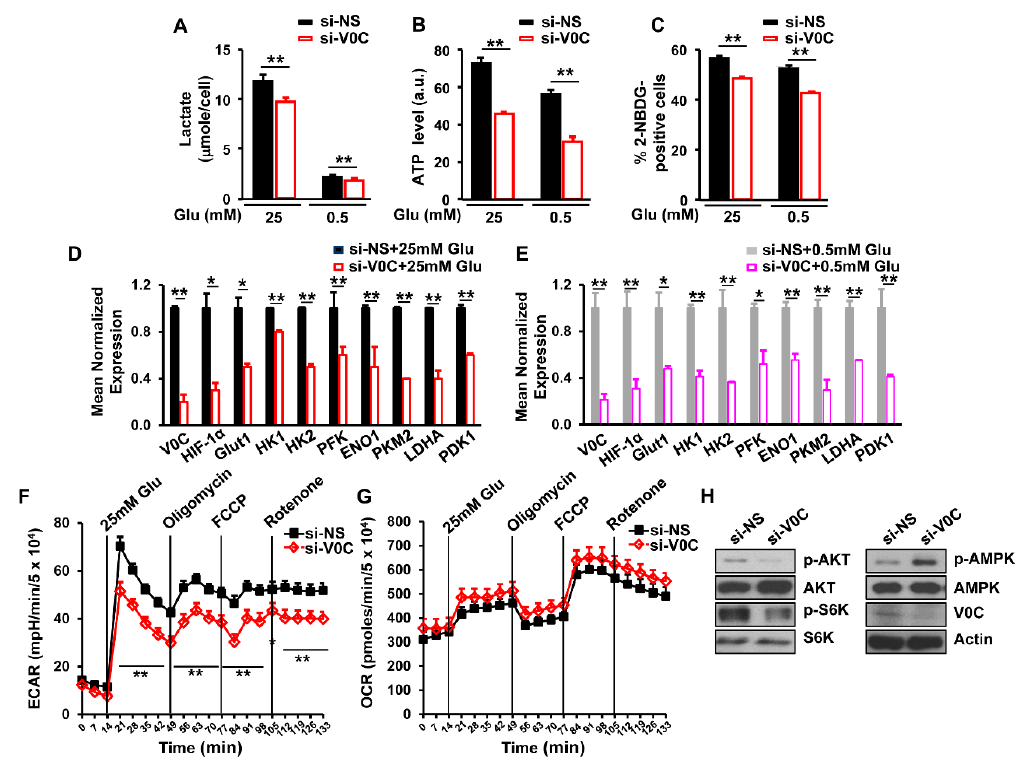
Figure 3. ATP6V0C depletion decreases glycolysis in ECCs. ( A,B ) Effects of ATP6V0C depletion on lactate or ATP levels in TE8 cells. ( C ) Effect of ATP6V0C depletion on glucose uptake. TE8 cells were transfected with NS or si-V0C for 72 h and then were treated with 10 μ M 2-NBDG, a fluorescent indicator for direct glucose uptake. Glucose uptake was analyzed by flow cytometry. ( D,E ) Gene expression related to glycolytic enzymes or glucose transport in ATP6V0C-depleted TE8 cells by qRT-PCR. ( F ) Extracellular acidification rate (ECAR) or ( G ) oxygen consumption rate (OCR) in ATP6V0C-depleted TE8 cells after treatment of inhibitors. TE8 cells were starved of glucose for 1 h prior to initiation of the experiment. Inhibitors were added at indicated time points: 25 mM glucose, 1 mM oligomycin, 300 nM FCCP, and 100 nM rotenone. Experiments were conducted in the absence of sodium pyruvate. ( H ) Expression of indicated proteins in TE8 cells treated with NS or si-V0C. ( A – E ) Each data point is the average of three independent measurements. Values are mean ± SEM. (In ( A – E ), Student’s t -test; in ( F ) and ( G ), ANOVA; * p < 0.05; ** p < 0.01).